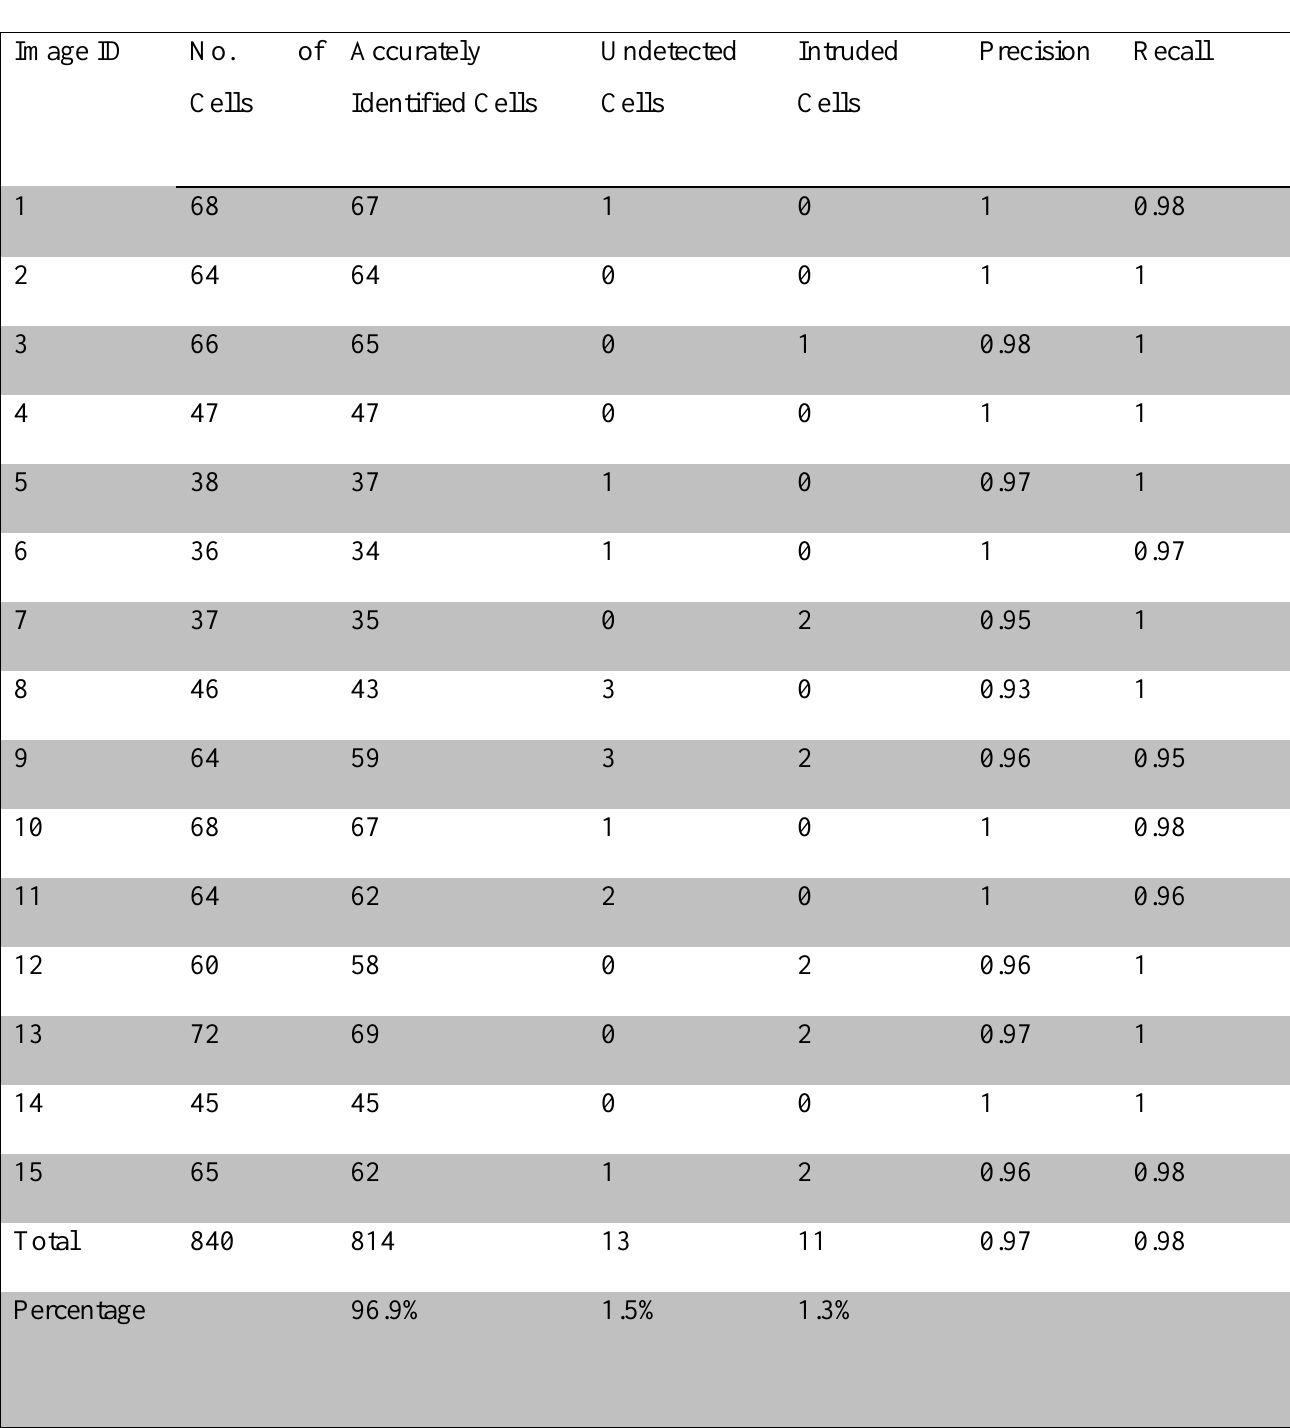
Table 2: Positive control images Class 2